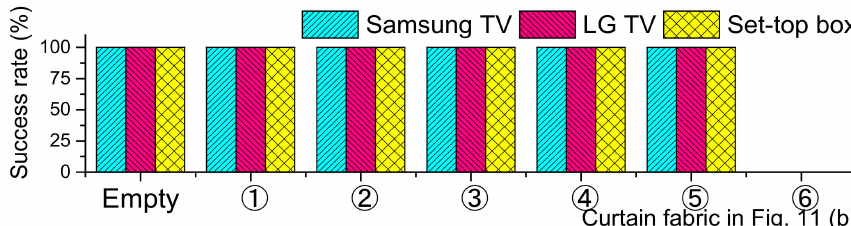
Figure 12. Success rate of eavesdropping behind curtain